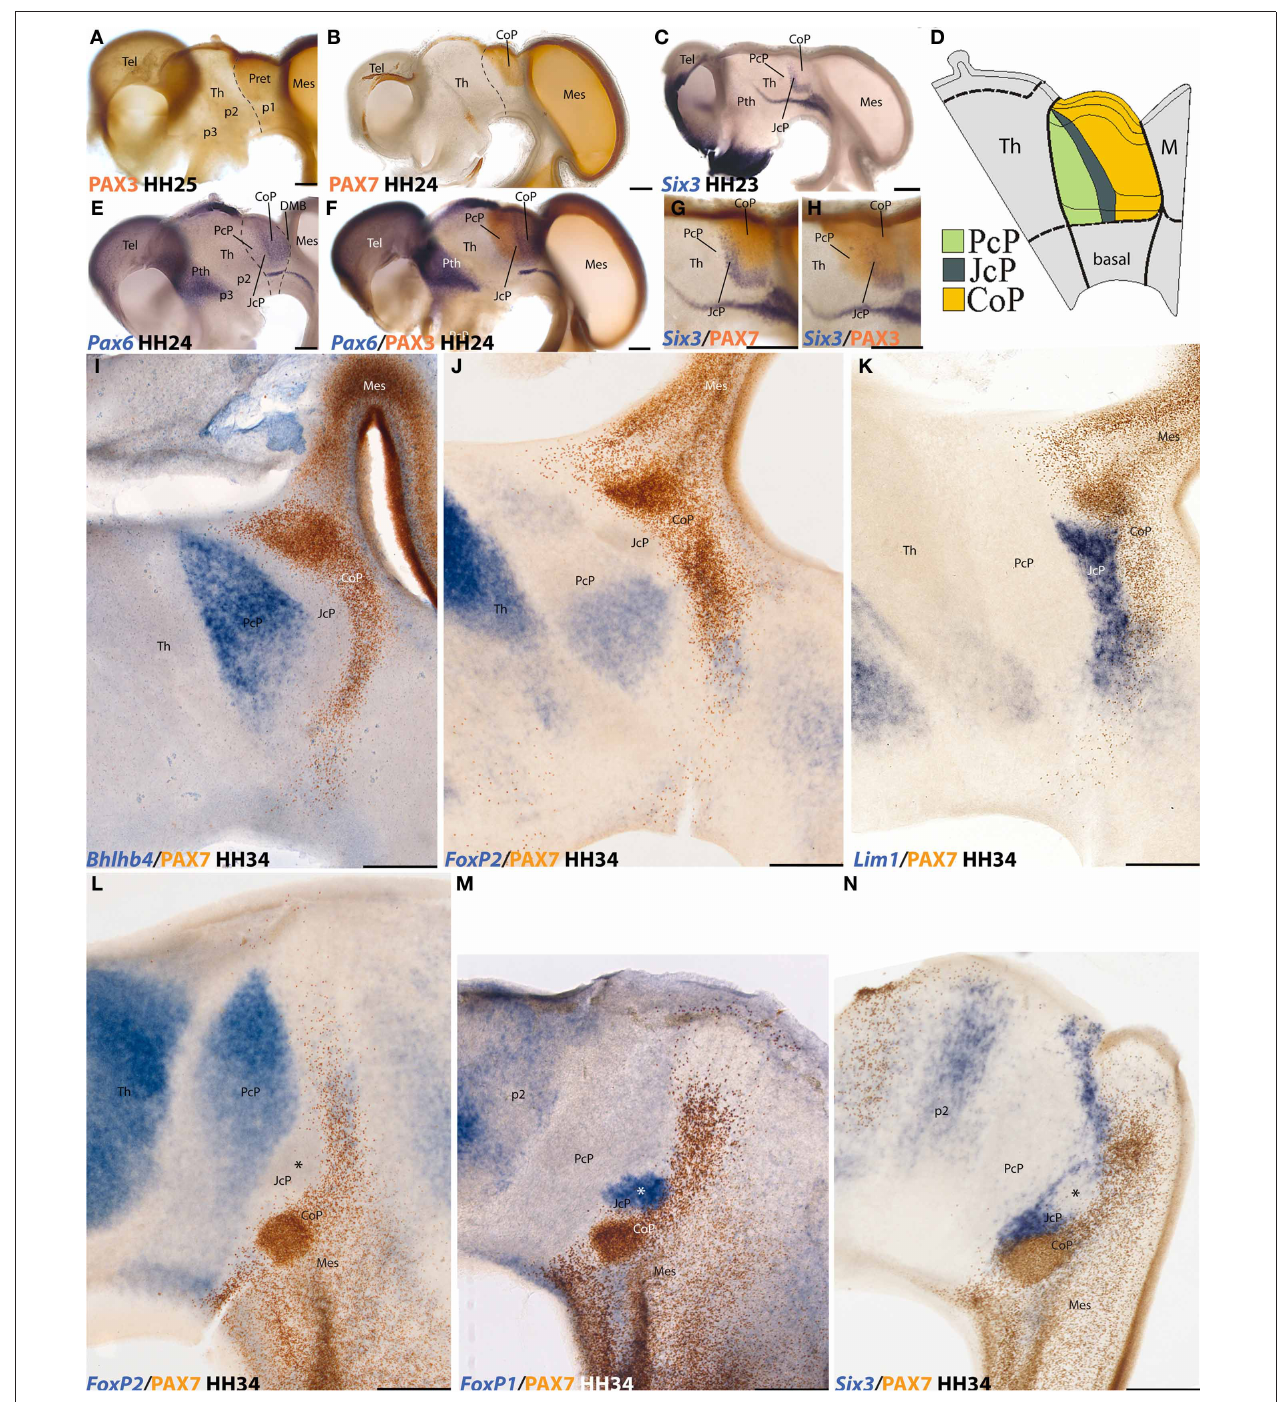
FIGURE 1 | Examples of neural genoarchitectonic analysis of the pretectal region in the chick brain, based on data reported by Ferran et al., 2007, 2009. Panels (A–H) show half-brain whole-mounts of embryonic chick brains at 4–5 days of incubation (HH stages are indicated), immuno-reacted or in situ reacted for various transcription factor genes that establish boundaries defining the pretectum and its main inner subdivisions. Pax3 marks the pretecto-thalamic border (A) , also drawn in (B) . Pax7 is restricted to a caudal pretectal domain, identified as “commissural pretectum” (CoP in B ). Six3 labels a thin intermediate